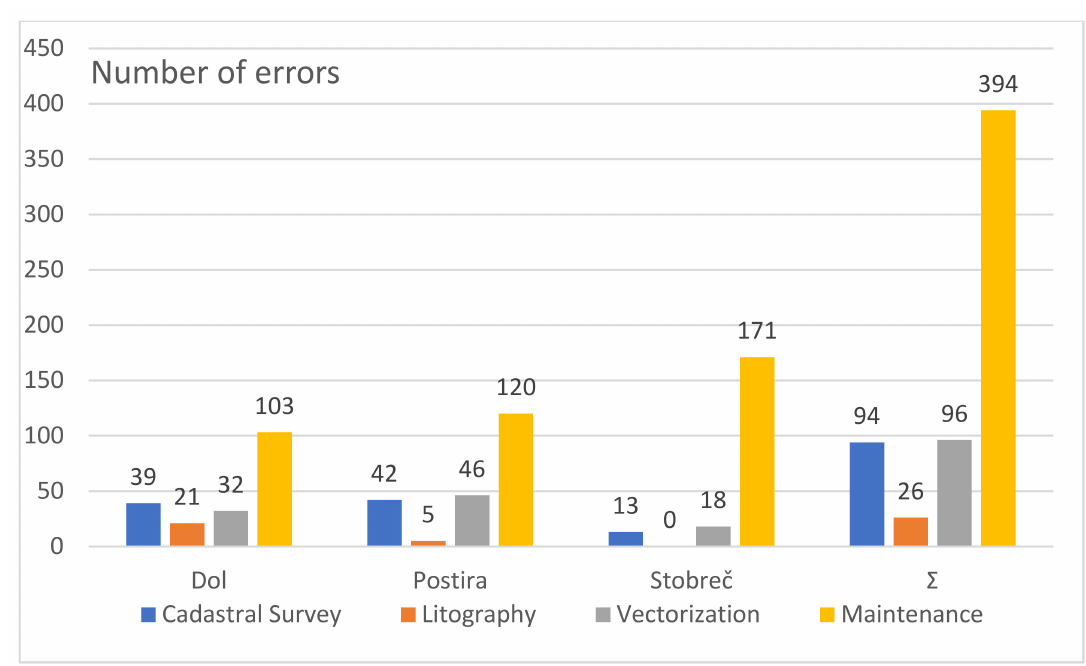
Figure 10. Inconsistency origin by cadastral municipality. Source: own